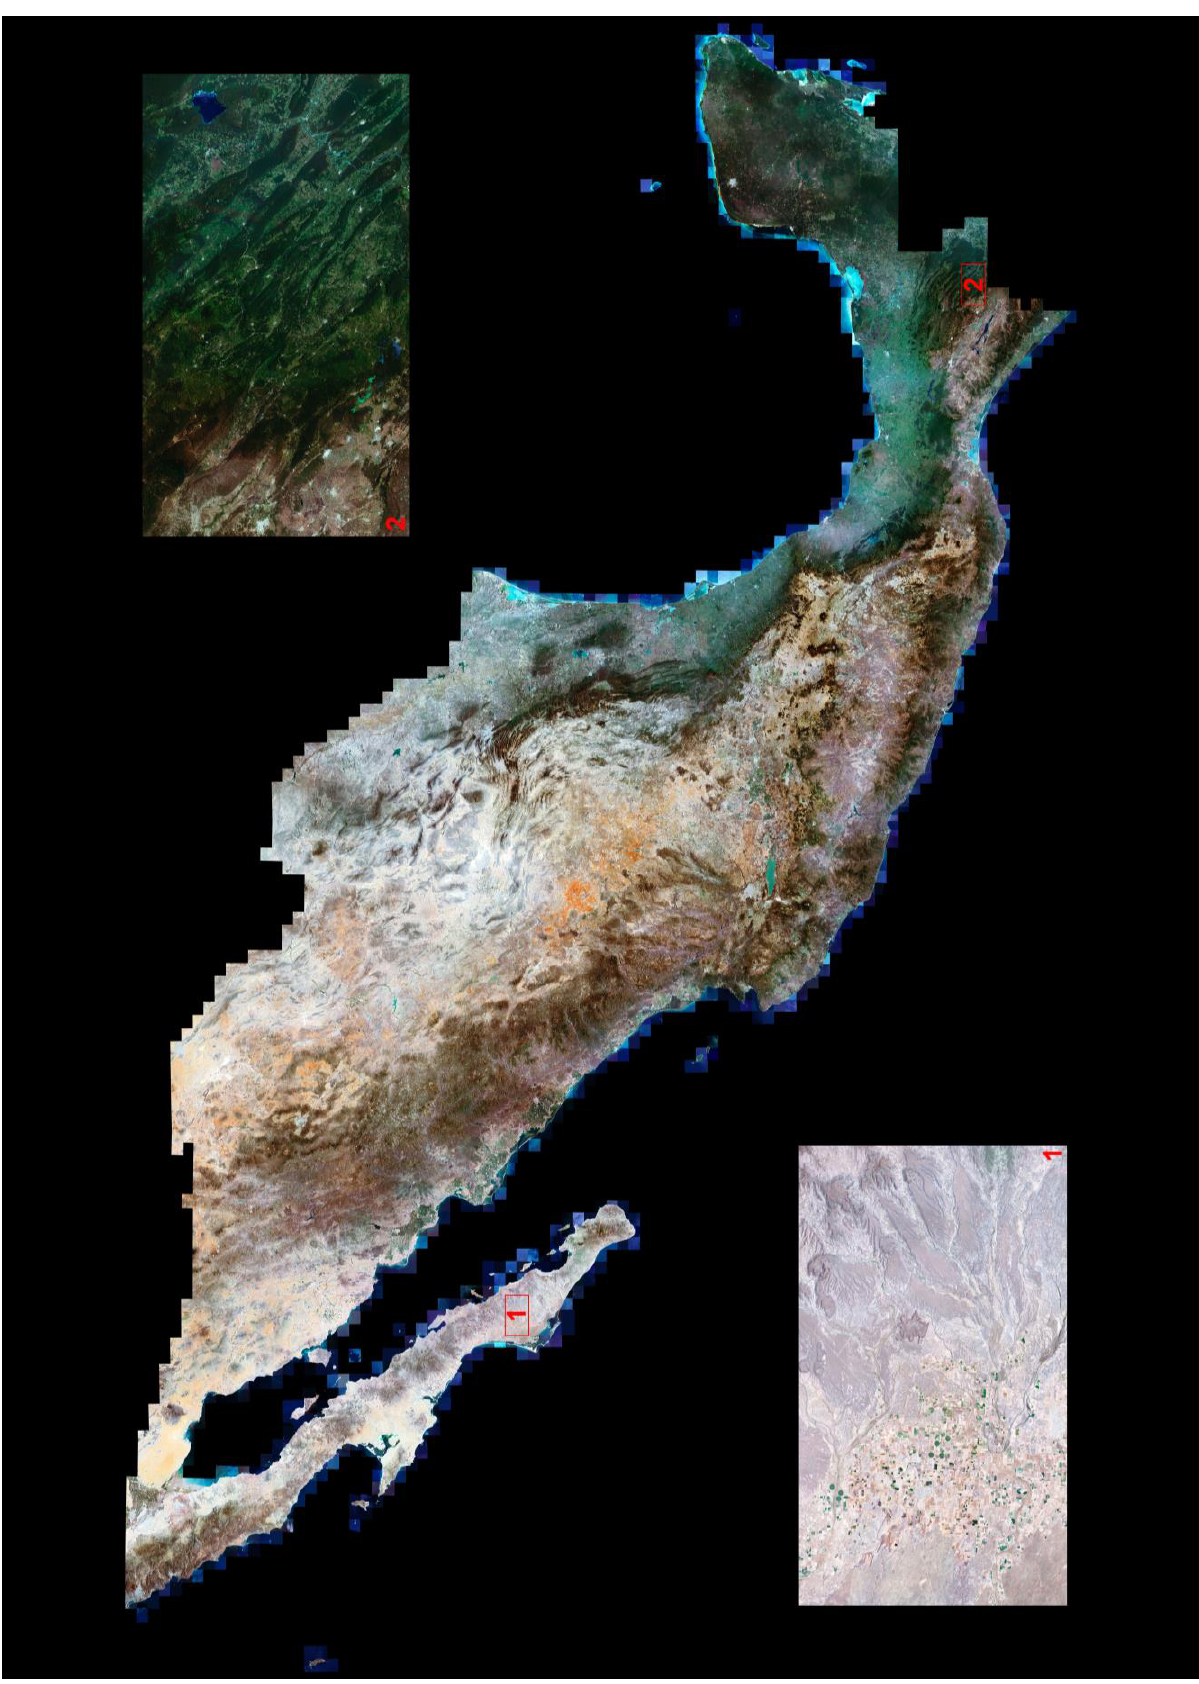
Figure 4. Prototype of the mosaic (incl. 4338 RapidEye scenes), detailing the Baja California Peninsula [1] and the Lacandon Jungle in Chiapas (Published online: